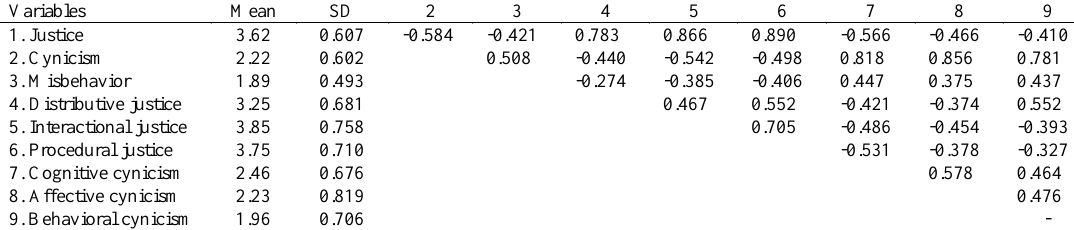
Table 1: Means, standard deviations, and correlations of the variables of interest Variables